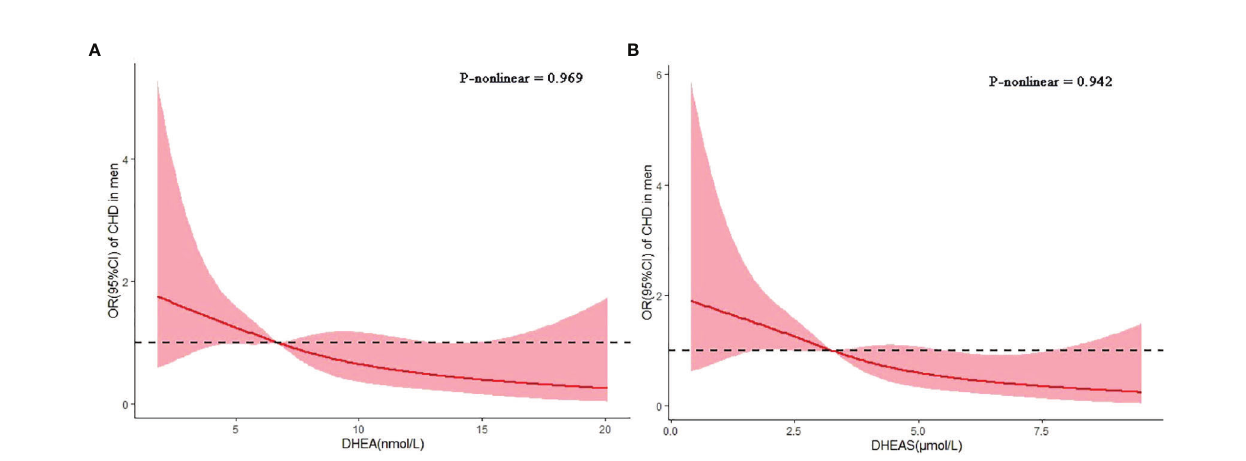
FIGURE 4 | Associations of dehydroepiandrosterone (DHEA) and dehydroepiandrosterone sulfate (DHEAS) with coronary heart disease (CHD) in men with type 2 diabetes mellitus. Restricted cubic splines were used to assess the dose – response associations of DHEA (A) and DHEAS (B) with CHD after adjusting for age, current smoking, current drinking, insurance type, body mass index (BMI), duration of diabetes, systolic blood pressure (SBP), low-density lipoprotein cholesterol (LDL-C), fasting blood glucose (FBG), glycosylated hemoglobin (HbA1c), and the use of glucagon-like peptide 1 (GLP-1) receptor agonists or sodium – glucose cotransporter 2 (SGLT-2) inhibitors. The p -values for nonlinear associations were 0.969 and 0.942 for DHEA and DHEAS,